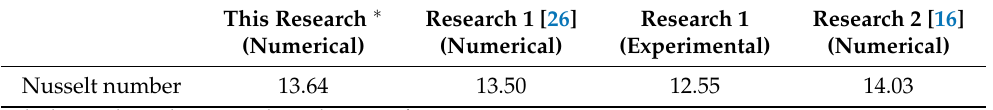
Table 7. Nusselt number validation.